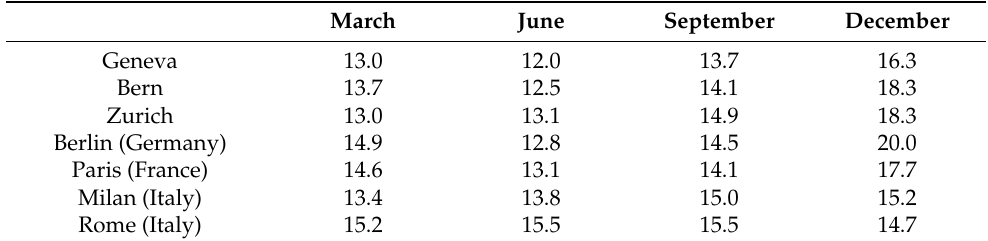
Table 1. Predicted equilibrium moisture content (M%) in outdoor sheltered structures for four different months in a number of cities within, north of, and south of the Alps